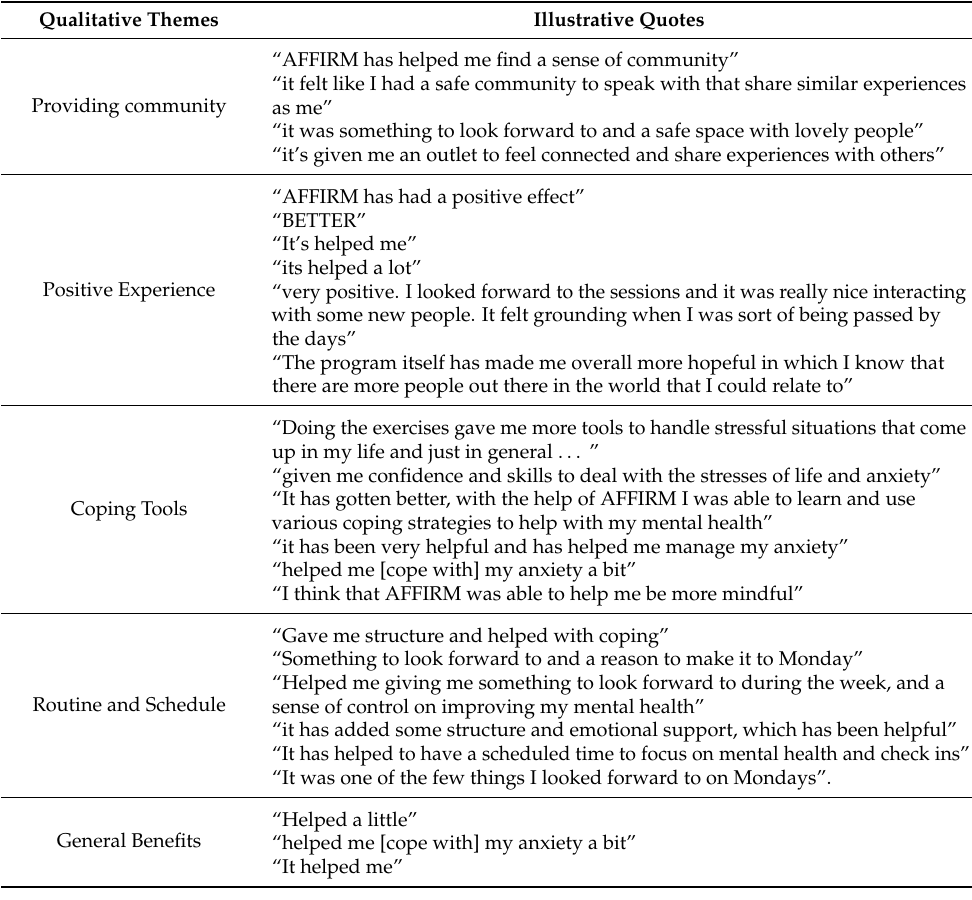
Table 5. Qualitative acceptability of AFFIRM